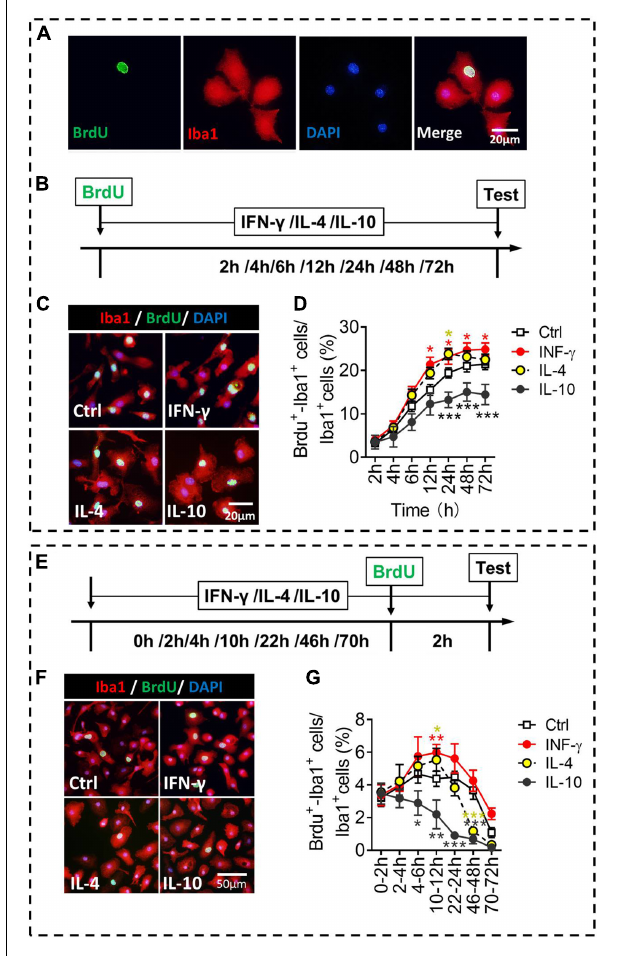
FIGURE 5 | Proliferative ability of microglial phenotypes induced by IFN- γ , IL-4, or IL-10. (A) Representative micrographs showing immunocytochemical labeling for BrdU (green) and Iba1 (red) in microglia. Cells double-labeled with BrdU and Iba1 were considered to be proliferating microglia. (B) Experimental scheme to monitor proliferation ability during activation. (C) Representative micrographs showing immunocytochemical labeling for BrdU and Iba1 in microglia treated for 24 h with IFN- γ , IL-4, or IL-10. (D) Quantification of the percentages of BrdU + -Iba1 + cells following treatment with IFN- γ , IL-4, or IL-10 for 2–72 h. (E) Experimental scheme to monitor proliferation ability after activation for 2–72 h. (F) Representative micrographs showing immunocytochemical labeling for BrdU and Iba1 in microglia treated for 22 h with IFN- γ , IL-4, or IL-10, followed by treatment for 2 h with BrdU. (G) Quantification of the percentage of proliferating microglia during 2 h after treatment with IFN- γ , IL-4, or IL-10 for 2–72 h. Five, 40 × micrographs were taken from each well, and all cells in the field were measured. Data are presented as mean ± SEM ( n = 5–6 well per group), * P < 0.05, ** P < 0.01, *** P < 0.005 (one-way ANOVA with Tukey’s multiple-comparisons